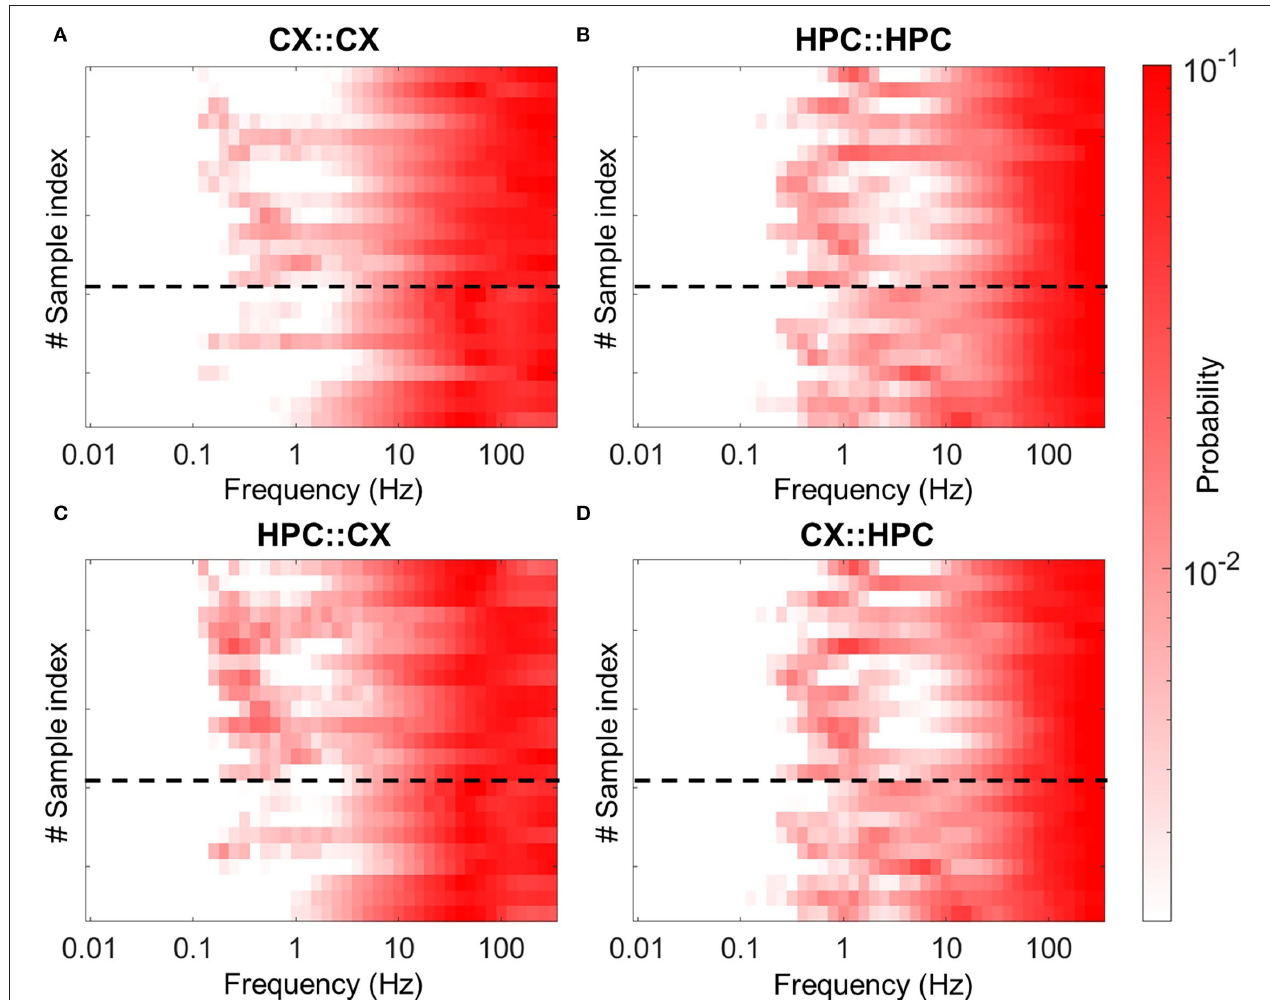
FIGURE 8 | Inverted ISI heatmap of evoked responses in heterogeneous cocultures. Samples expressing different modes of activity coupling are separated by the black dotted line. Samples that express the first mode of coupling (CX, 20–40Hz; HPC, 4–10Hz; lower part of heatmap) show low-gamma–like activity after either CX network stimulation (A) or HPC network stimulation (C) . Consistently, the HPC network in samples with the same coupling mode express theta-wave–like activity in response to either HPC network stimulation (B) or CX network stimulation (D) . In contrast, samples that express the second coupling mode (CX, 0.1–0.5Hz; HPC, 1Hz) show an activity rhythm similar to that seen in spontaneous